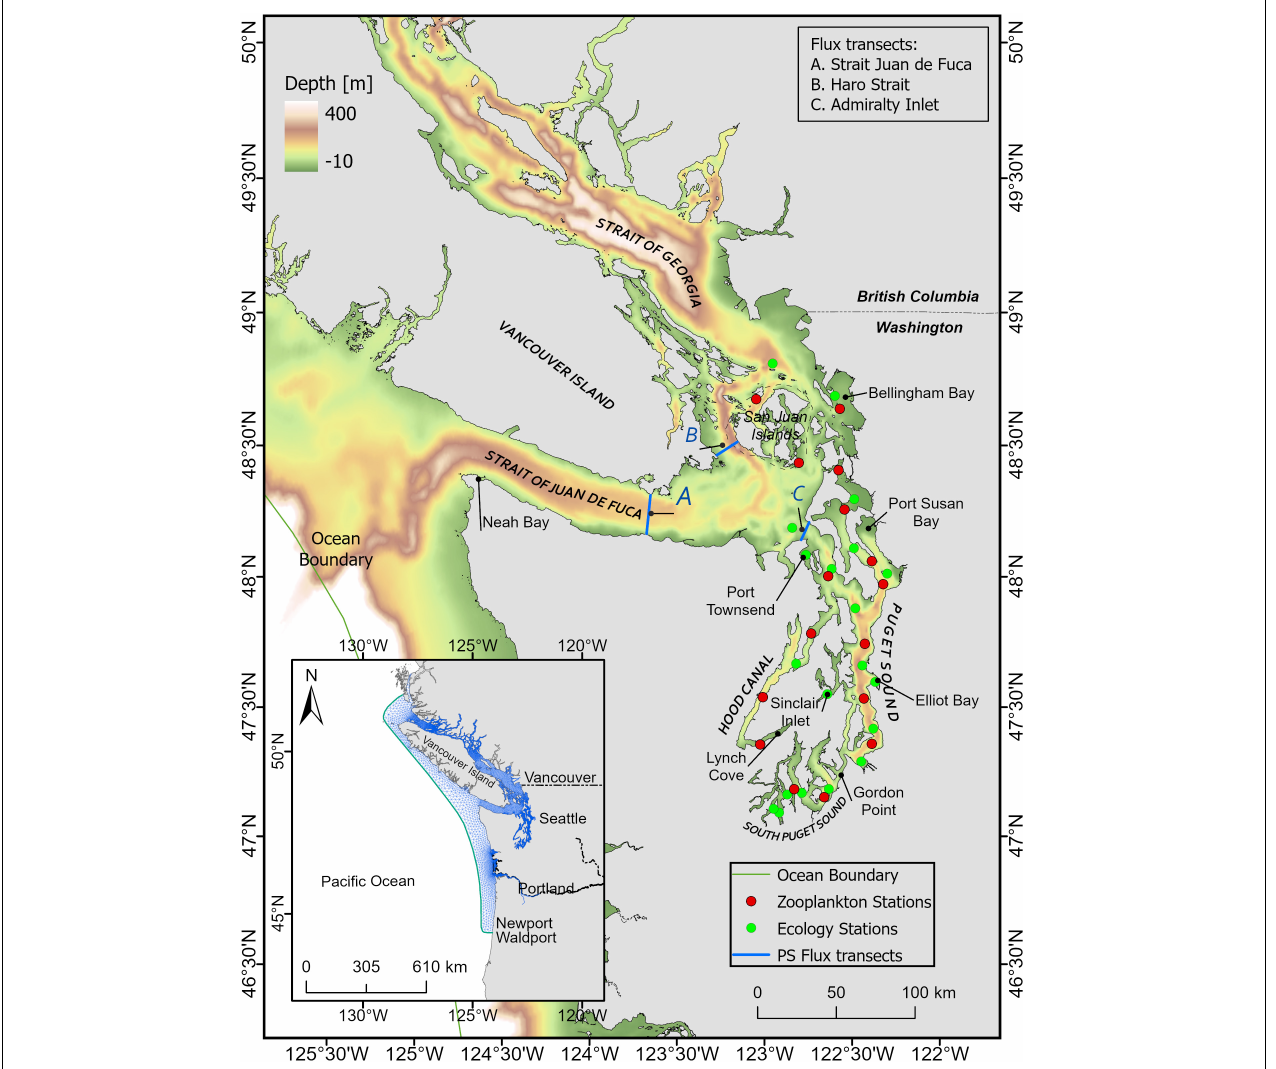
FIGURE 1 | Oceanographic regions of the Salish Sea (Puget Sound, the Strait of Juan de Fuca, and the Strait of Georgia). Inset shows the entire model domain. Monitoring data stations include Ecology monthly monitoring sites (green) and Puget Sound zooplankton monitoring sites (red). Transects A, B, and C are locations where volume flux (exchange flow) calculations were